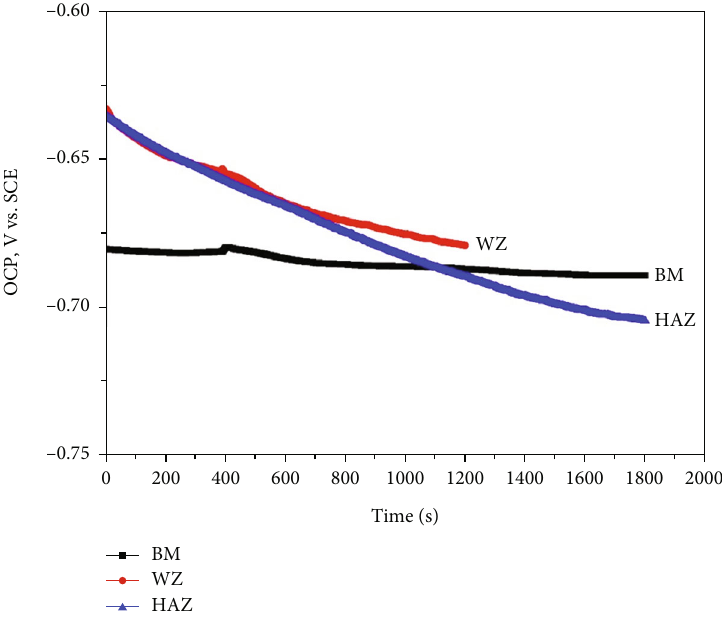
Figure 9: Open circuit potential in di ff erent areas of welded joints.